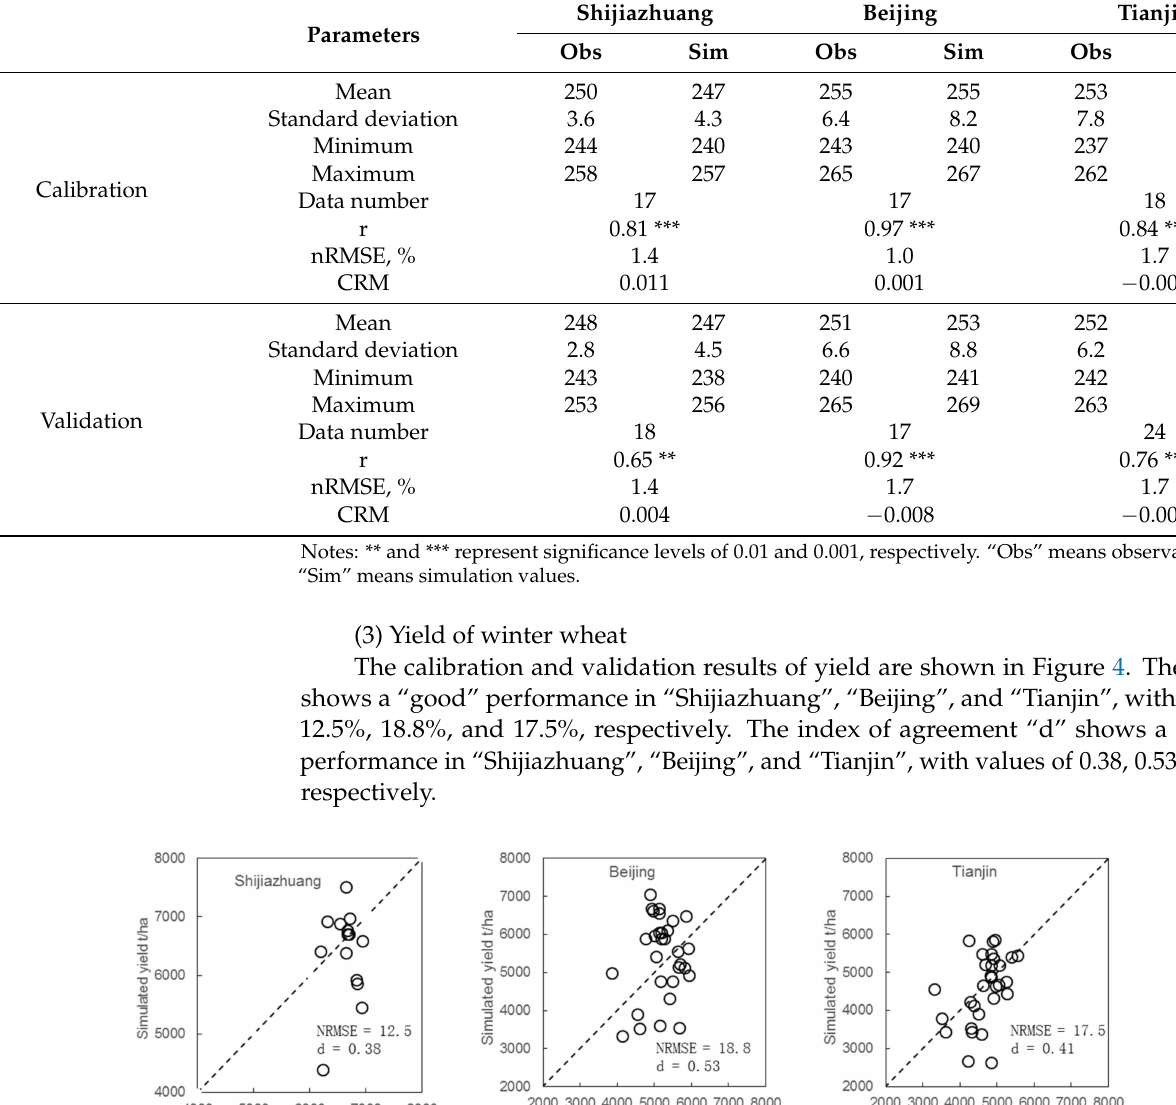
Table 5. Calibration and validation results of the DSSAT model for maturity dates. Parameters